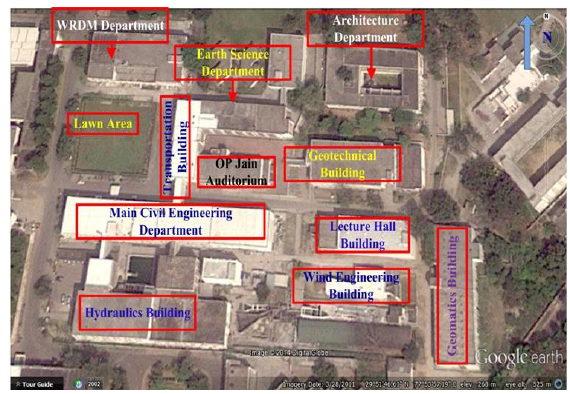
Figure 1: Department of Civil Engineering, IIT-Roorkee, (Uttarakhand), India ( Source: Google Earth, January